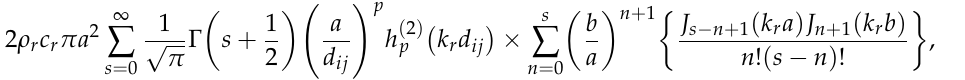
Figure 4. Equivalent circuit of the cymbal array.